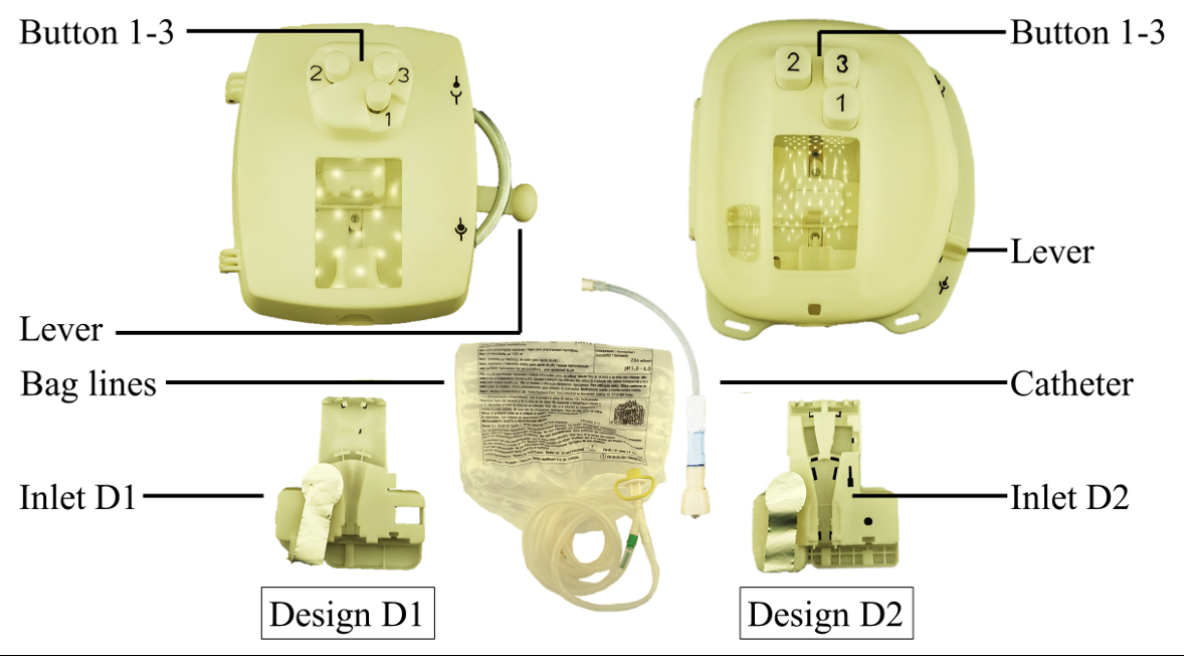
Figure 1. Illustration of user interface designs D1 (left) and D2 (right) including features lever and buttons 1-3. Additional parts for the therapy handling with the medical device are bag lines and catheter (standard parts used in therapy) and inlets D1 and D2, compatible with their respective